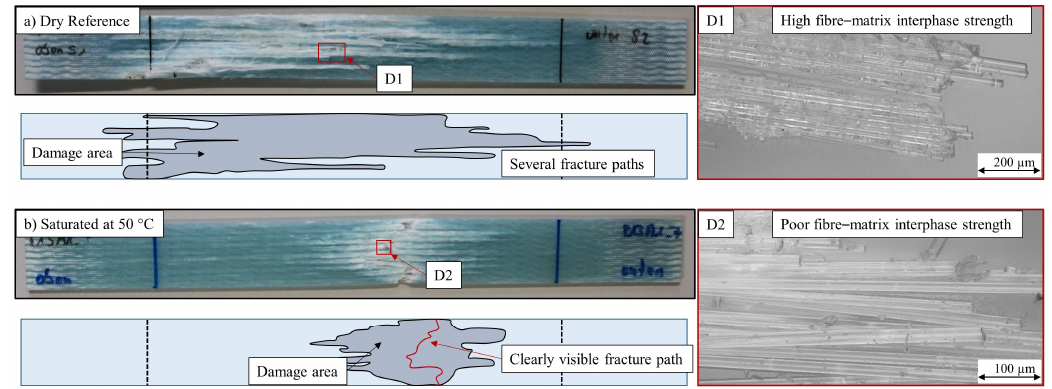
Figure 10. Photographs, micrographs, and schemes of the fracture area after static tensile tests. The damage area and the fibre–matrix bond strength decrease significantly with hygrothermal ageing. Re-drying tensile specimens at 50 °C vacuum for 94 days results in nearly complete water desorption, where only 0.01 wt.% remain inside the composite. Nevertheless, the tensile strength remains at a level about 33% lower than in the initial dry state. The tensile strength increase of 15% in comparison with the saturated state might be mainly attributed to the ability of the matrix to regain its mechanical strength and stiffness to a large extent [39]. For the same amine epoxy matrix resin used within this work, Krauklis et al. [39] pointed out that the static tensile and fatigue properties are almost reversible by re-drying after hygrothermal immersion to saturation at 60 °C. Therefore, the